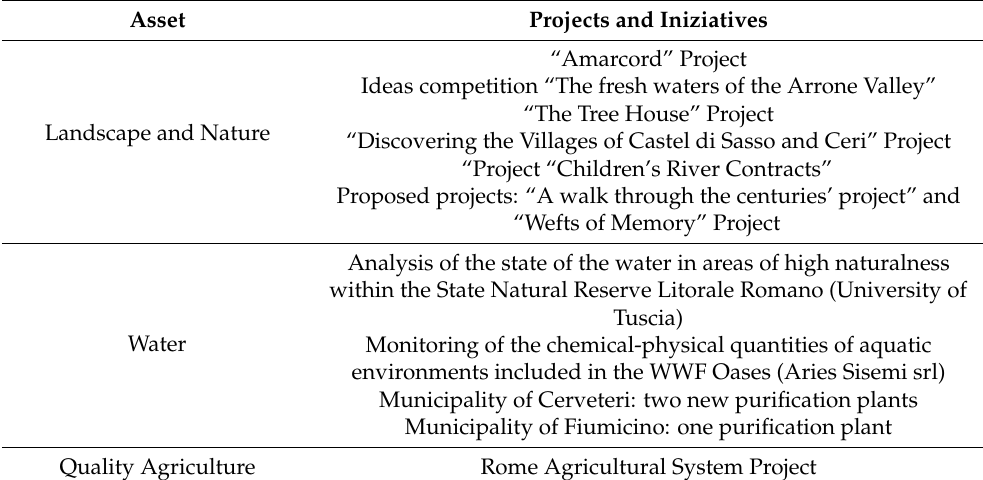
Table 4. The initiatives carried out for enhancing the process, according to the five assets of the River, Coastal, and Landscape Contract Arrone. Source: Authors’ elaboration (2022) from data of the official web site of the contract available at https://contrattodifiumearrone.it/documentazione-progettuale/ (accessed on 20 July